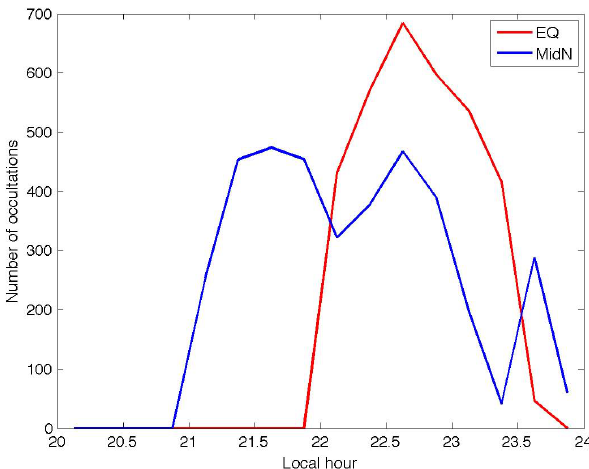
Fig. 2. Number of occultations as a function of the local time for GOMOS dark limb occultations (solar zenith angle greater than 107 ◦ ) in 2004 for two latitude belts. The red line: 5 ◦ S–5 ◦ N, the blue line: 40 ◦ N–50 ◦